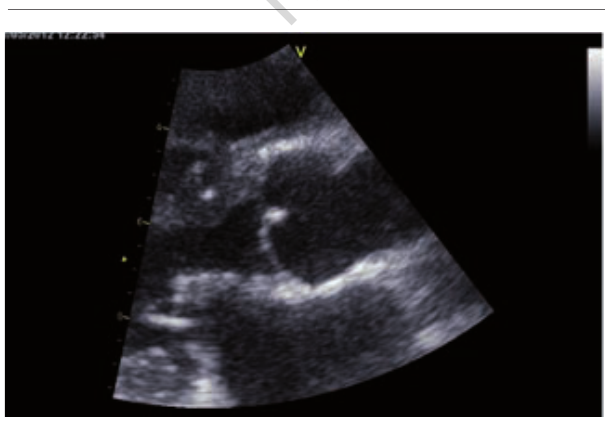
Figure 14. A 21-year old boy affected by mucolipidosis type III: the echocardiographic aspect of the aortic valve is similar to mucopolysaccharidosis valve disease.